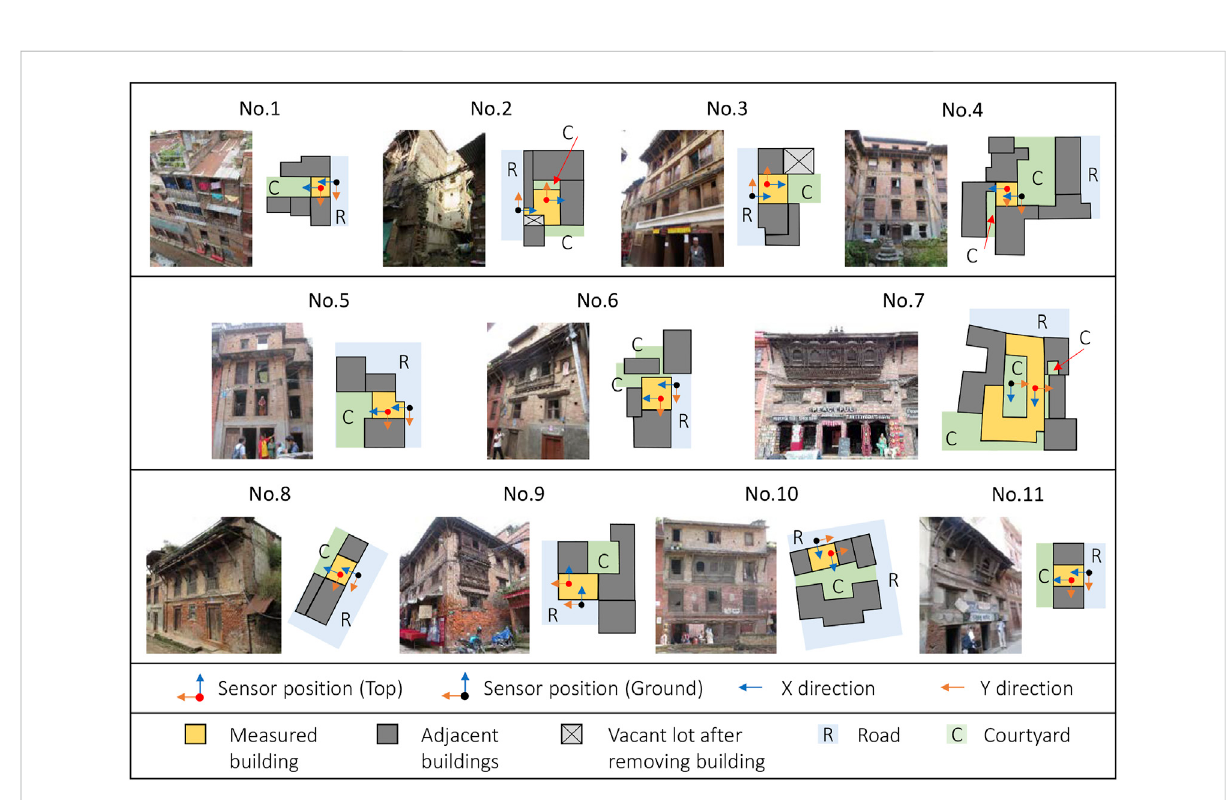
FIGURE 3 Building arrangement and exterior view of the measured